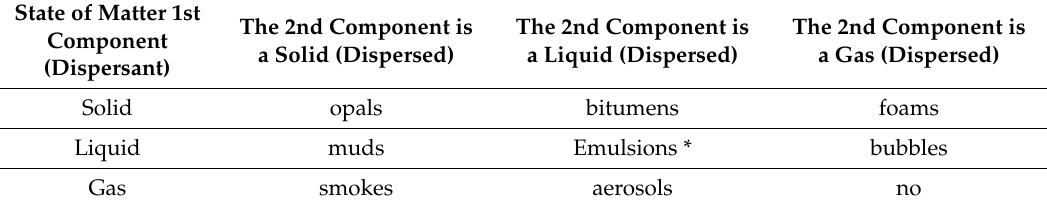
Table 1. Possible colloid dispersion modes.